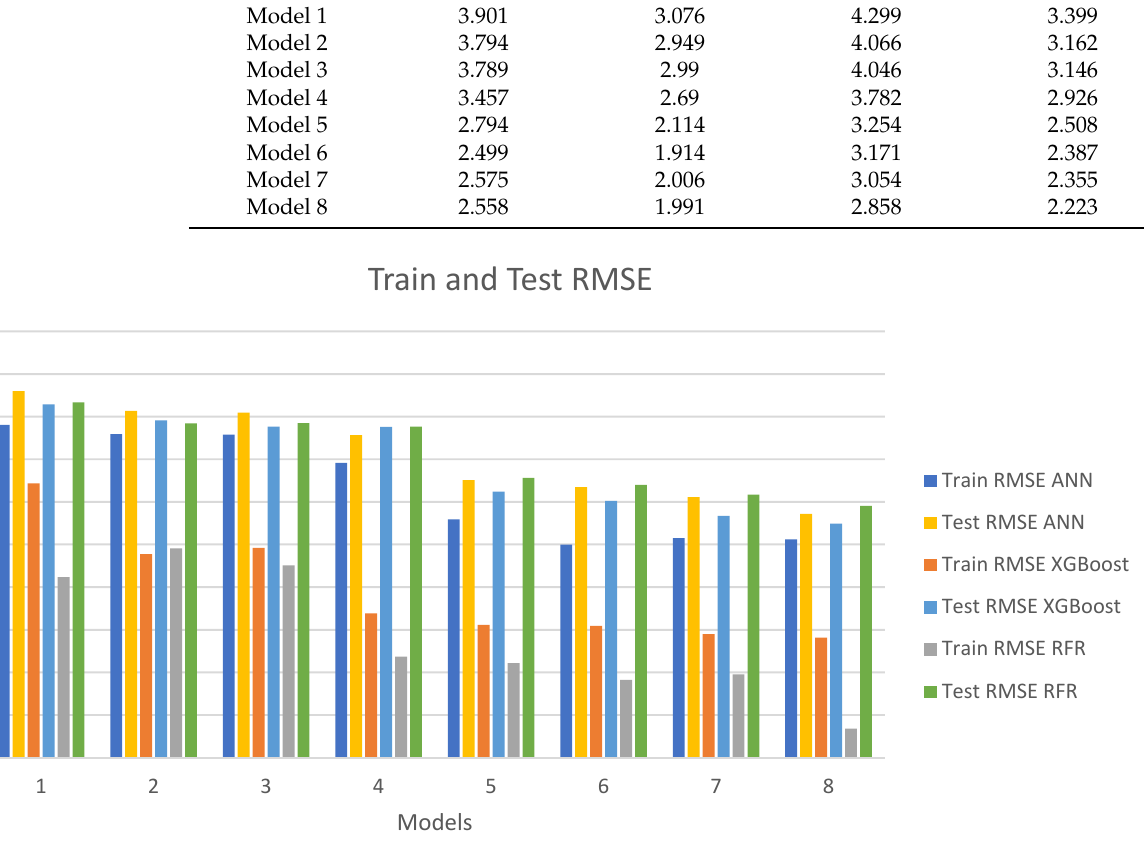
Figure 10. Train and test RMSE for all methods.